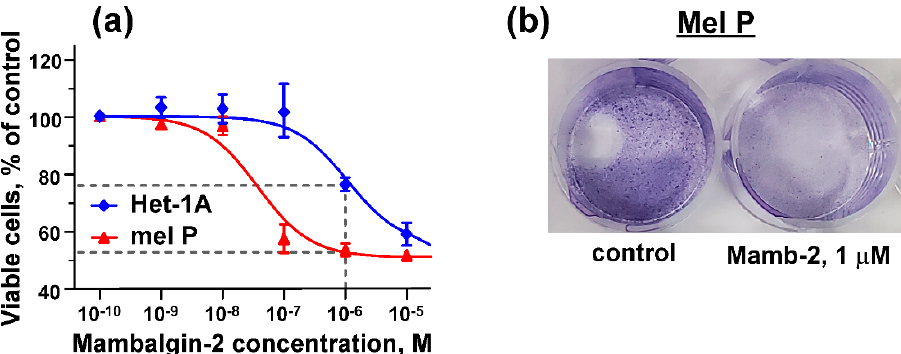
Figure 5. Influence of mambalgin-2 on growth of mel P and Het-1A cells: ( a ) effect of different mambalgin-2 concentrations on Het-1A and mel P cells cultivated at pH 6.5. The parameters describing the concentration-effect curves (EC 50 , A 1 ) are: 37,3 ± 1.3 nM and 1009 ± 170 nM, 51.4 ± 2.3% and 55.4 ± 6.2%, for mel P and Het1-a cells, respectively. Data are presented as% of the control (untreated cells) ± SEM ( n = 4). The difference between EC 50 of the mambalgin-2 effect on mel P and Het-1A cells is statistically significant by F test ( p < 0.001, n = 4); ( b ) picture illustrating the colony formation by mel P cells in absence (control) or presence of 1 µ M mambalgin-2 according to the crystal violet